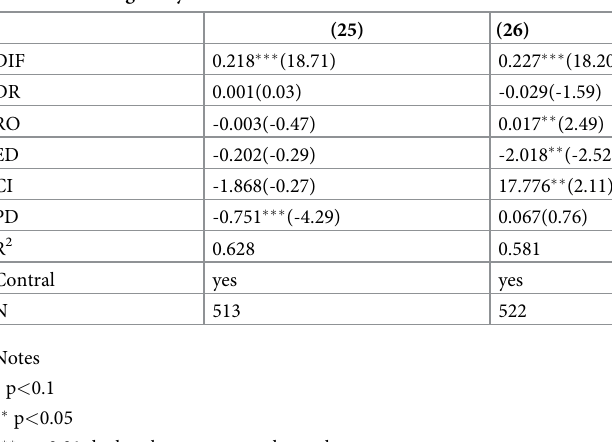
Table 9. Heterogeneity of innovation